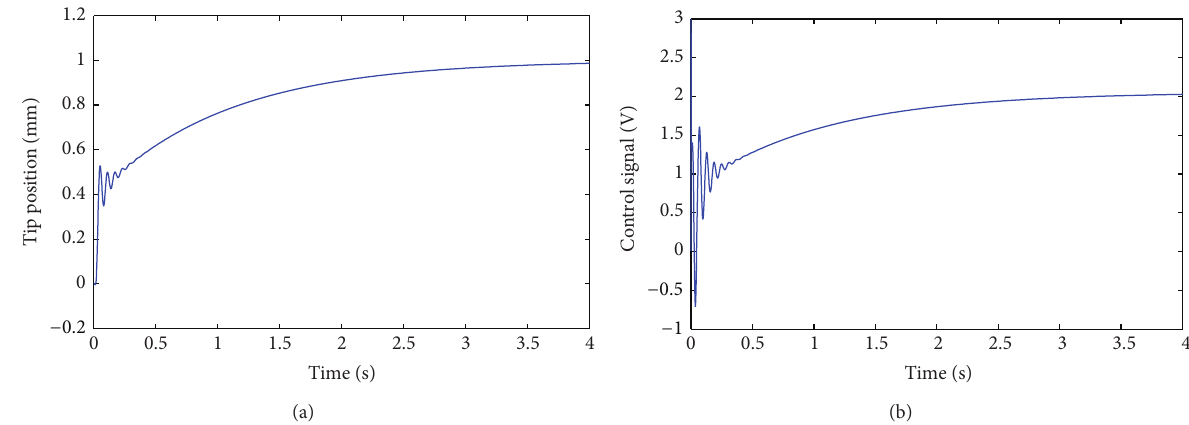
Figure 5: Step response of the closed-loop FE model using the integer PID controller: (a) tip position, (b) control signal. 050